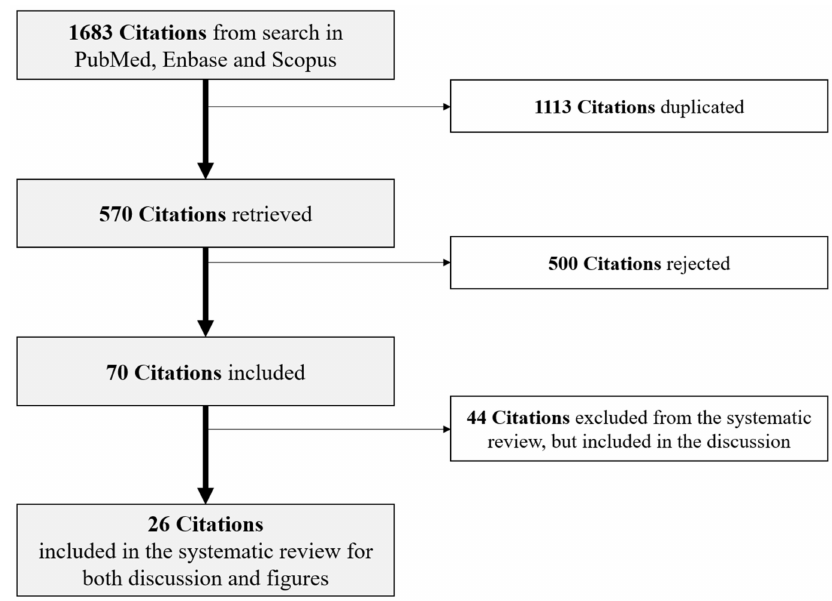
Figure 1. Flow chart showing screening and inclusion of the eligible